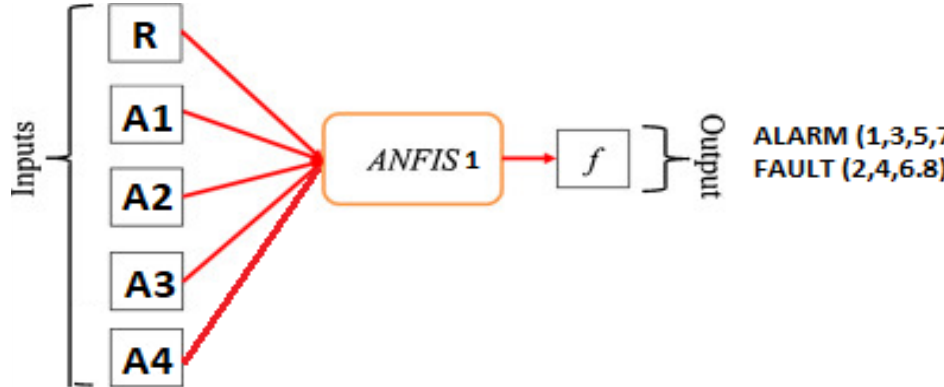
Figure 4. Block diagram of ANFIS controller 1.